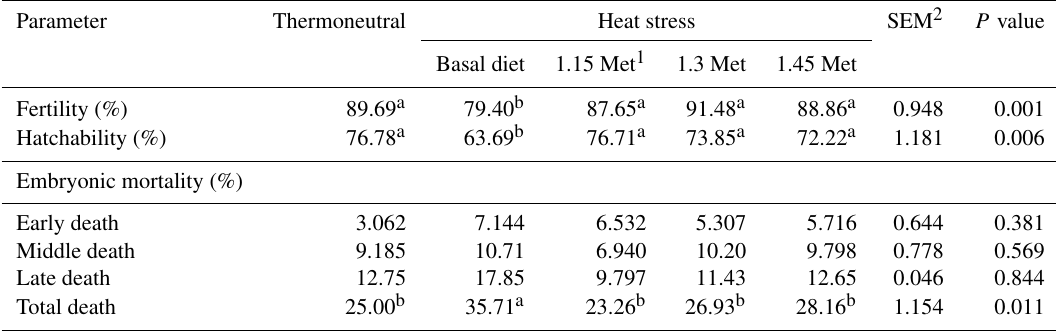
Table 4. Effect of methionine on fertility, hatchability and embryonic mortality in breeder quails. Parameter